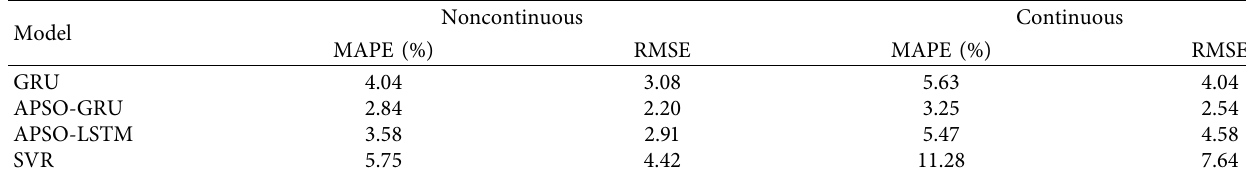
Table 7: Error comparison of traffic flow speed prediction